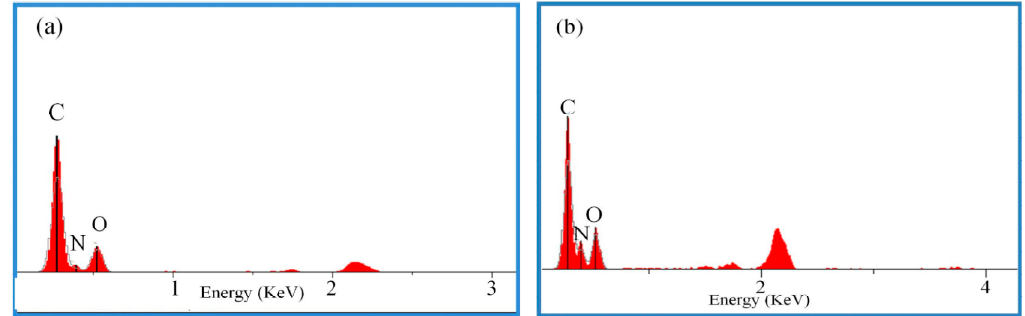
Figure 4. EDS spectra of samples: ( a ) for NC/GAP; ( b ) for NC/GAP/nano-LLM-105. Table 1. Theoretical elemental contents from EDS analyses.